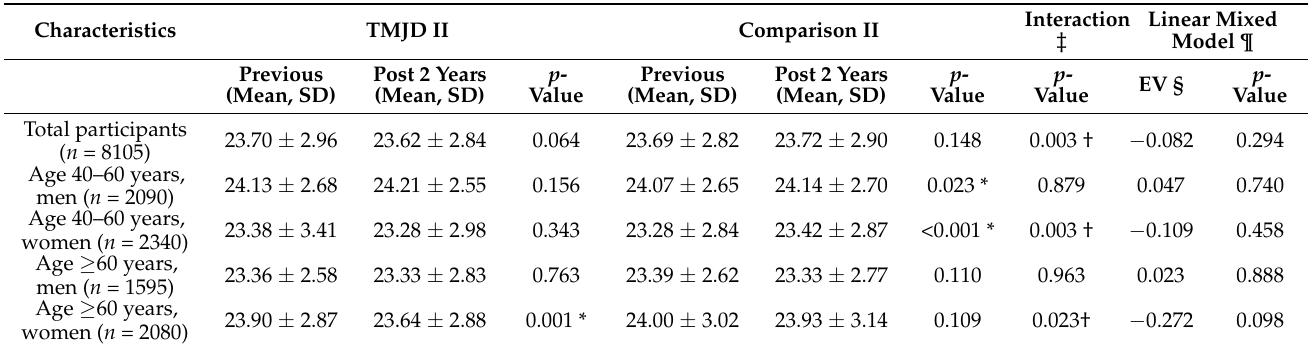
Table 4. Differences in mean BMI between pre- and 2-year-post-study of TMJD in Study II according to age and sex.